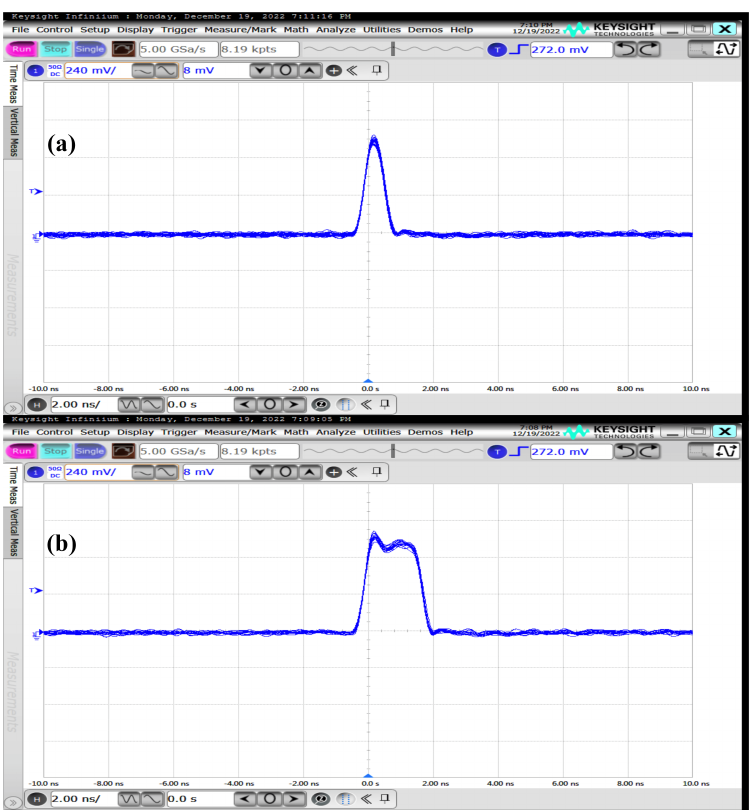
Figure 8. Different laser pulse widths: ( a ) Laser pulse width of 1 ns. ( b ) Laser pulse width of 2 ns.